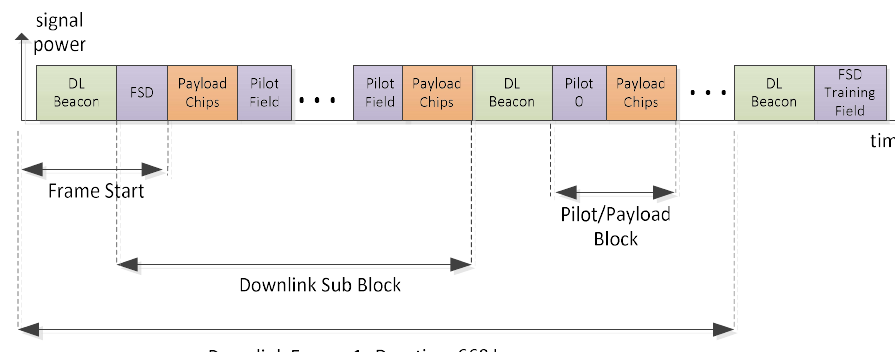
Figure 6. ICARUS downlink burst structure.